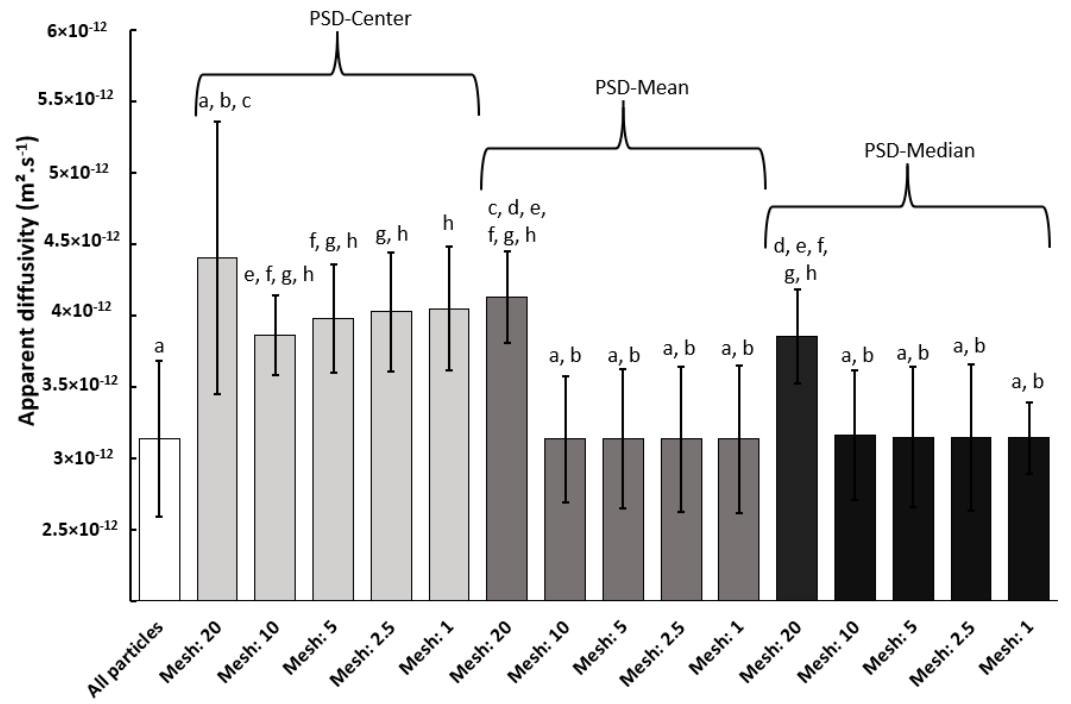
Figure 8. Mean values of apparent diffusivity for different shape descriptors and size meshes. Similar letters in indicate similar means ( p > 0.05).